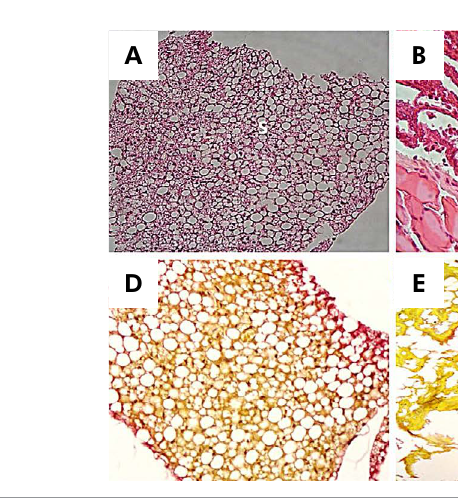
Figure 5. The H&E (A, B and C) and alizarin red (D, E and F) staining images of the developed tissue 6 weeks after transplantation (x20). (A): The granular structure of the scaffold (s) in the negative control group. (B): The increase in connective tissue cells and the formation of granulation-like tissue in the (-) group. (C): The increase in odontoblast-like cell density, tissue organization, vascularization (v) and osteo-dentin matrix (om) formation in the (+) group. (D): No mineralization foci in the negative control. (E): Mild mineralization in the (-) group. (F): Increased calcification and mineralized areas (arrow) in the (+)